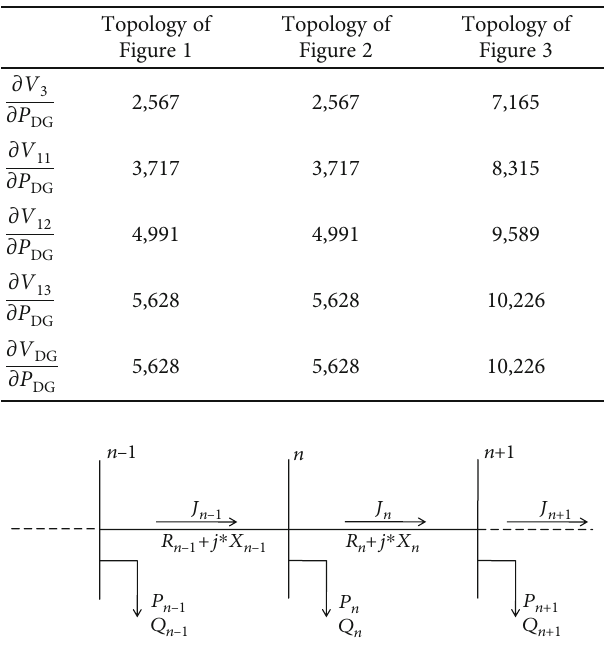
Figure 2: Single-line diagram of nodes “ n , ” “ n − 1 , ” and “ n + 1 .